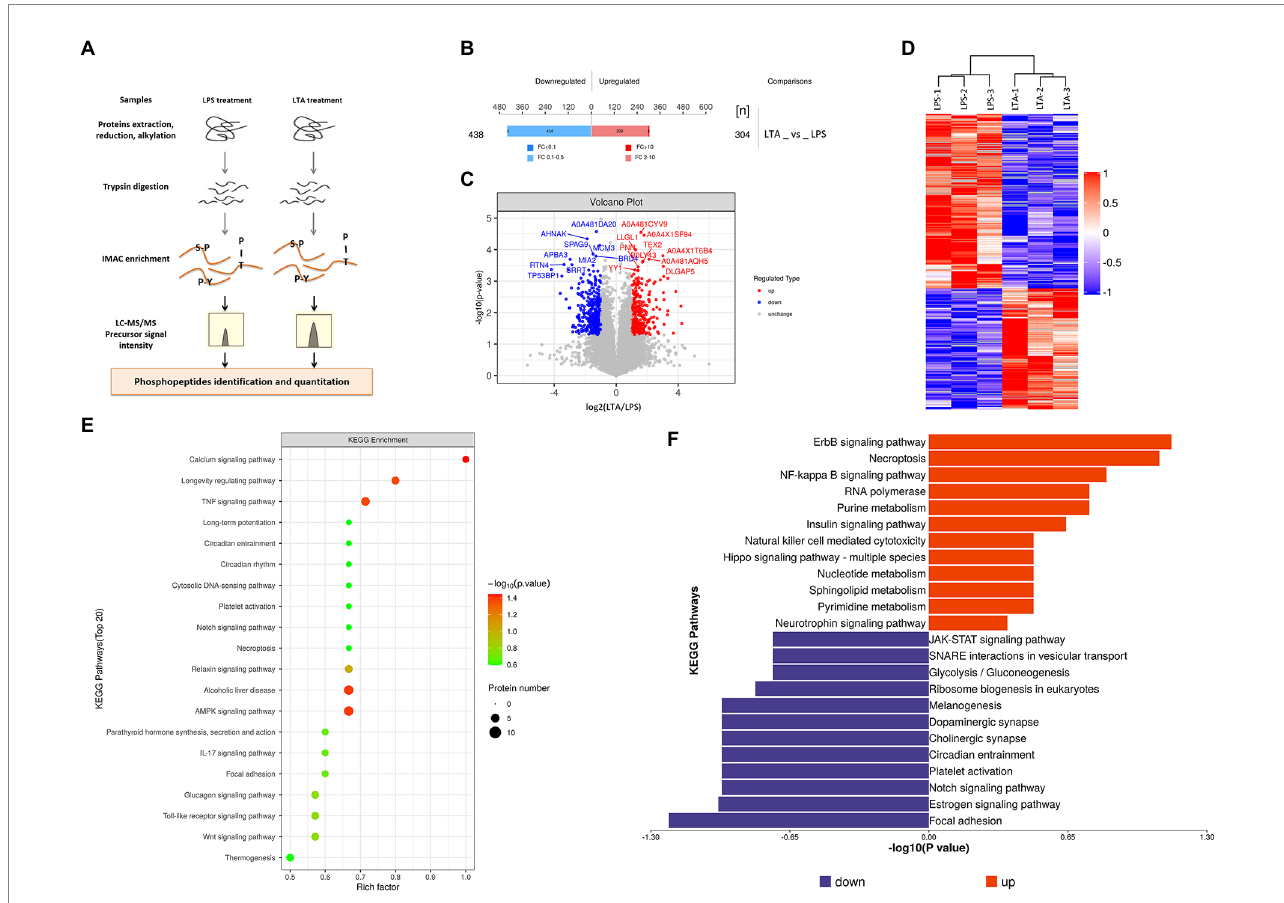
FIGURE 5 Phosphorylated modification of proteins after LPS and LTA stimulation. (A) Overview of the workflow of phosphorylated proteomics. (B) Histogram of quantitative differences in phosphorylated peptides between the LPS and LTA groups. (C) Volcano plot shows the different phosphorylated peptide between the LPS and LTA groups. (D) Cluster analysis results of differential expression of phosphorylated peptide between LTA group and LPS group. (E,F) Enrichment results of KEGG pathway corresponding to phosphorylated peptides with differential expression between the LPS and LTA